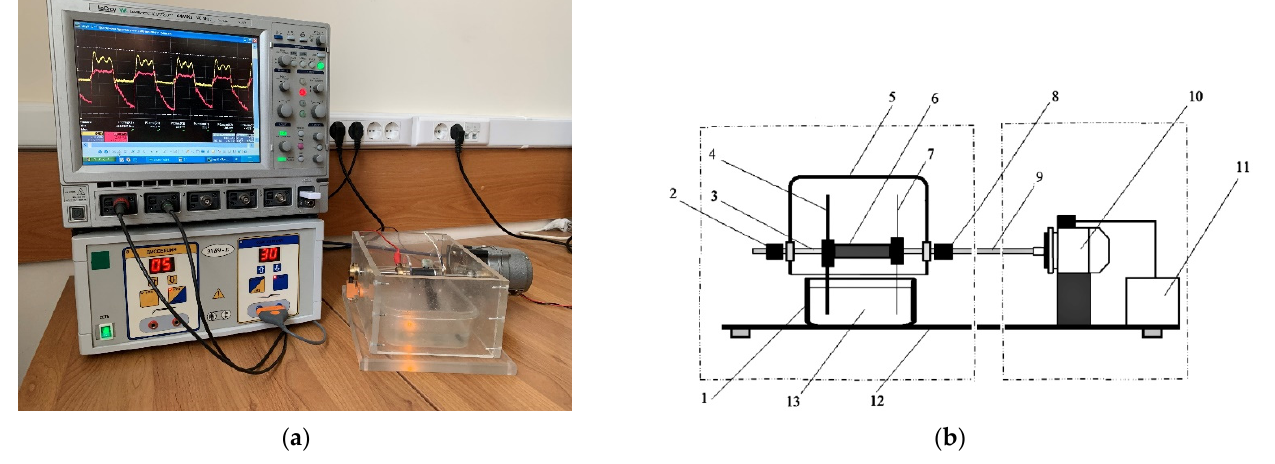
Figure 10. The photo ( a ) and the structure ( b ) of the PTS generator: 1—tank with activated solution; 2—neutral electrode (NE) brush; 3—rotor axis; 4—replaceable parts of the neutral electrode; 5— reactor lid; 6—dielectric loading; 7—replaceable active electrodes; 8—active electrode (AE) brush; 9—kinematic axis; 10—electric motor; 11—controlled power source; 12—platform; and 13—aqueous solution.